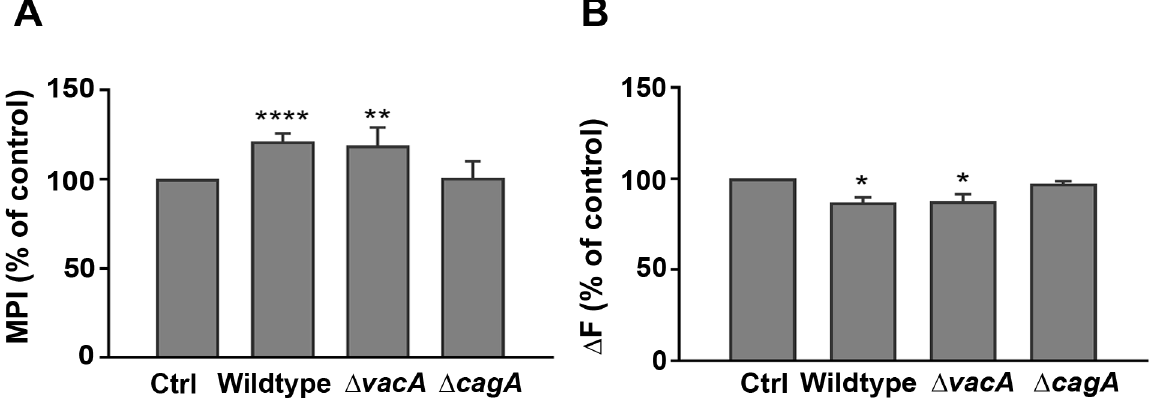
Fig 5. Labile iron pool in AGS cells infected with H . pylori CagA and VacA mutants. AGS cells infected with H . pylori (MOI, 10:1) for 15 h were (A) fixed and stainedwith sulphide-silver to detect lysosomal iron or (B) , treated with calceinwith and without the additionof SIH to measurethe cytosolic labileiron pool. (A) The mean pixel intensity (MPI) of each image was calculatedusing ImageJ software and evidenceof lysosomal iron in infected cells (indicatedby MPI) was expressedas a percentage of that observed in uninfected(Ctrl) cells. (B) Results reflect the increase in fluorescence ( Δ F) in cells infected with the wildtype, and VacA and CagA mutant strains of H . pylori strain 60190 presentedas a percentageof uninfectedcells. (A) Results are ± SEM of five images taken from three independent experiments and (B) , ± SEM of 3 independent repeats. * , ** , **** , results are statistically different from those of untreated controls (P < 0.05, < 0.01 and < 0.0001,respectively), as determined by one-wayANOVA with Tukey’s test for multiple